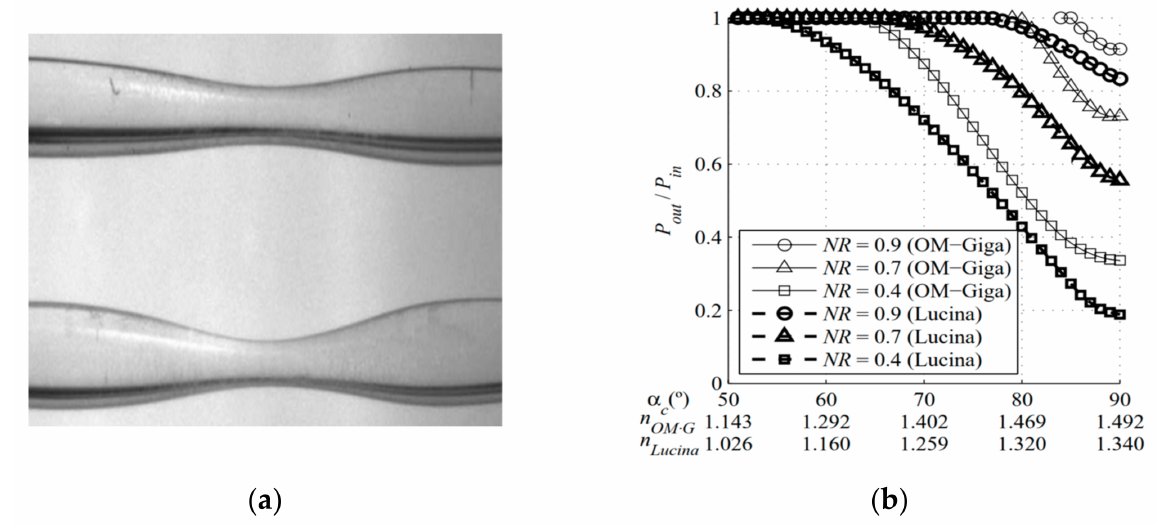
Figure 4. The photos of the tapered POFs ( a ), and the transmission behaviors of light for the OM- Giga/POF and the Lucina fibers with a different narrowing ratio in liquid with different RIs ( b ) [77].